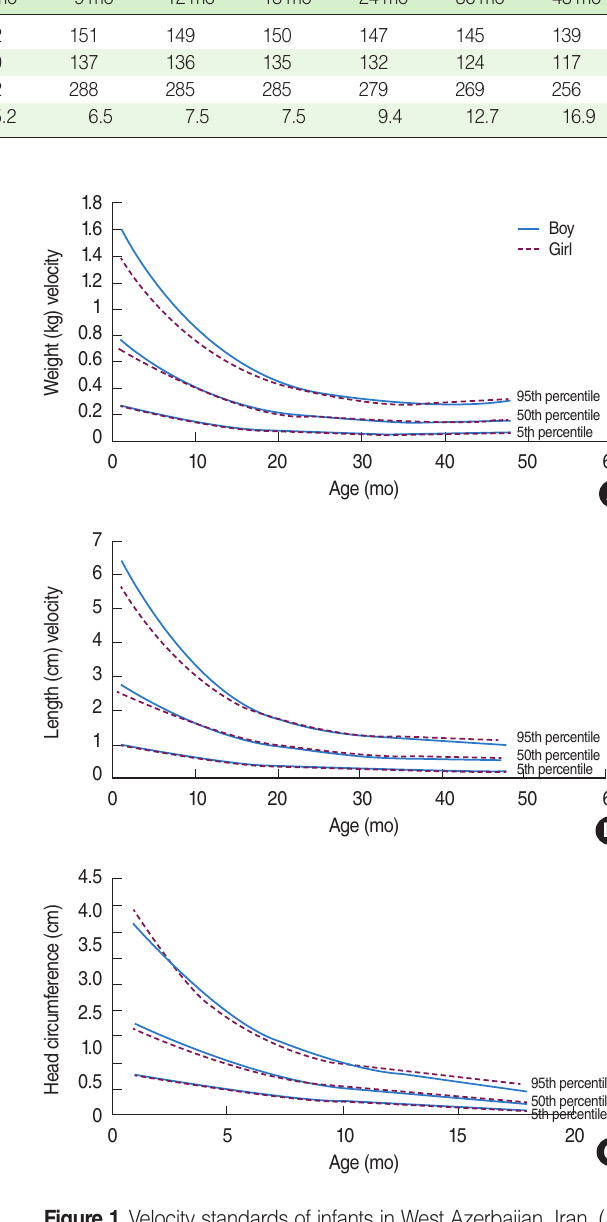
Figure 1. Velocity standards of infants in West Azerbaijan, Iran. (A) Weight (kg) velocity, (B) length (cm) velocity, and (C) head circum- ference (cm)